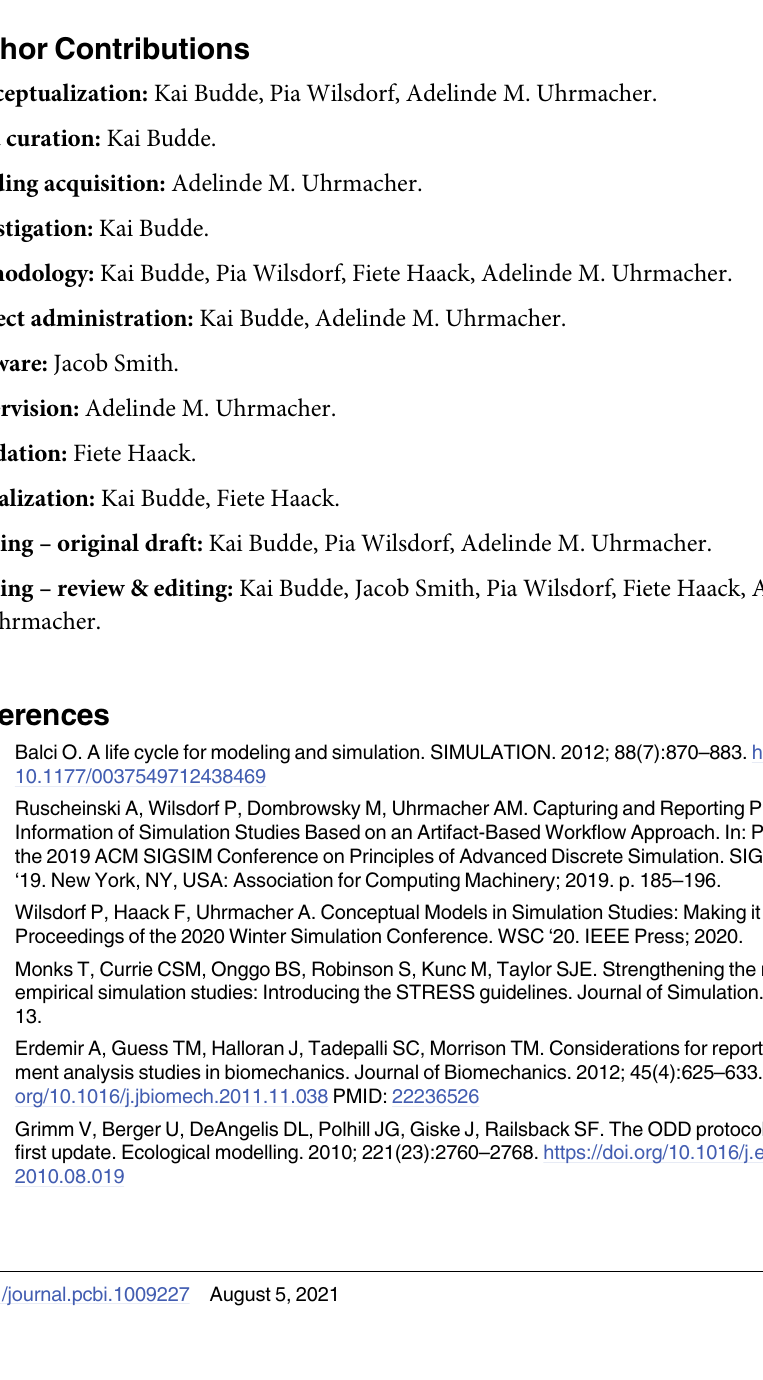
S1 Table. Categorized assumptions. We present the results of the categorization of all assumptions found in the 19 simulation studies using SBO. We have have also added informa- tion about the key words that accompanied the assumptions. S2 Table. Categorized simulation experiments. We present the results of the categorization of the simulation experiments found in the 19 simulation studies using our